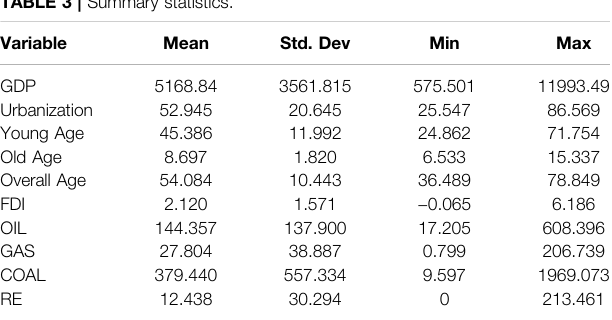
TABLE 3 | Summary statistics.